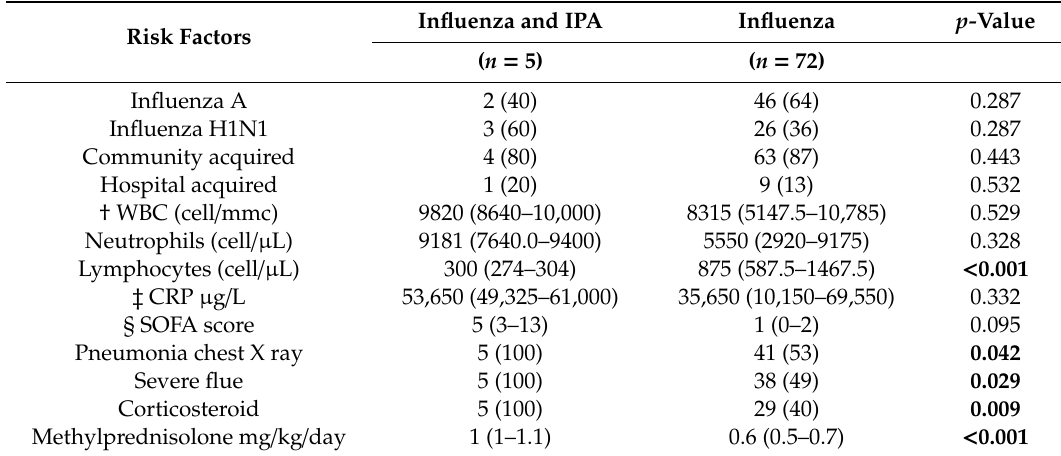
Table 3. Hospitalization-related risk factors associated with IPA in influenza patients.